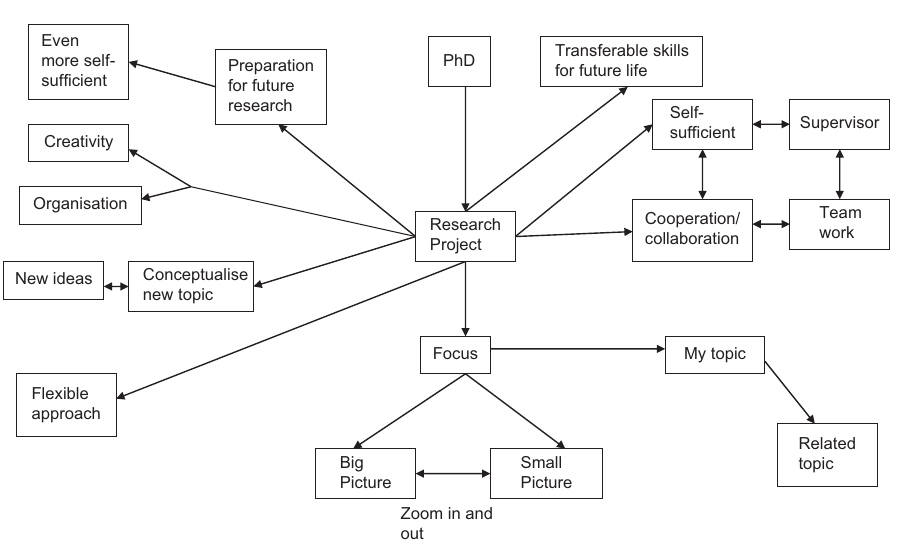
Figure 3. Supervisor A map of what a Ph.D.